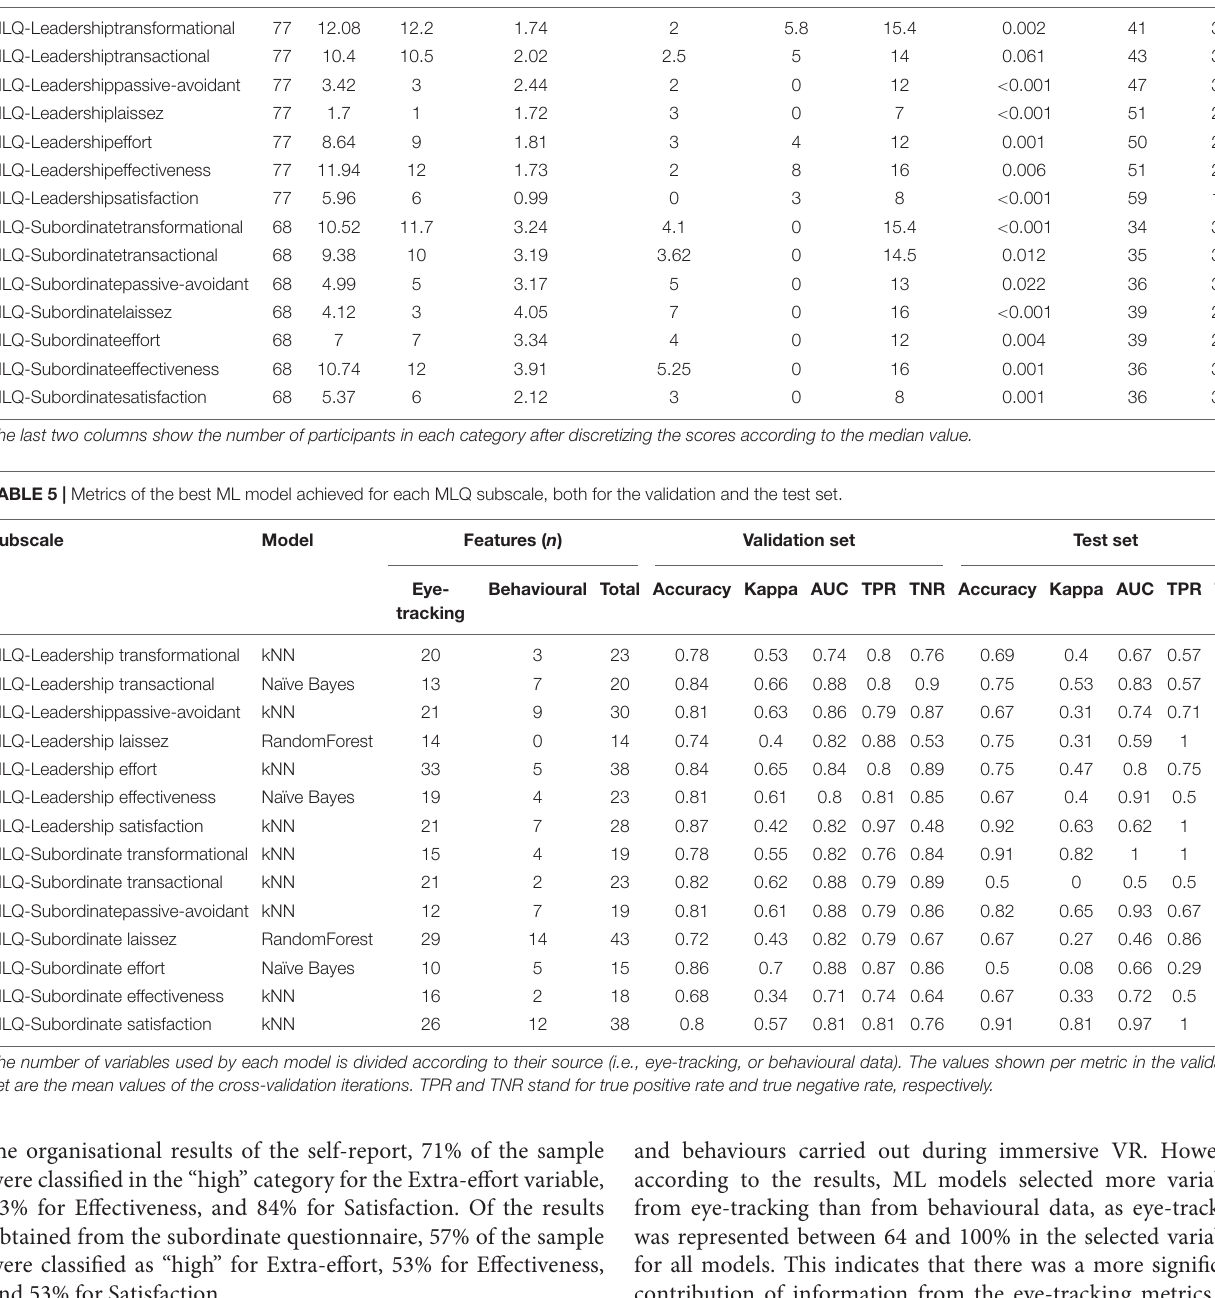
Interquartile Minimum Maximum deviation range